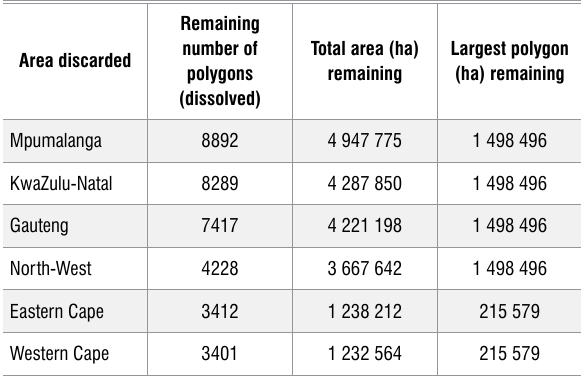
Polygons identified as potential target areas for conservation within the Grassland Biome of South Africa grouped into